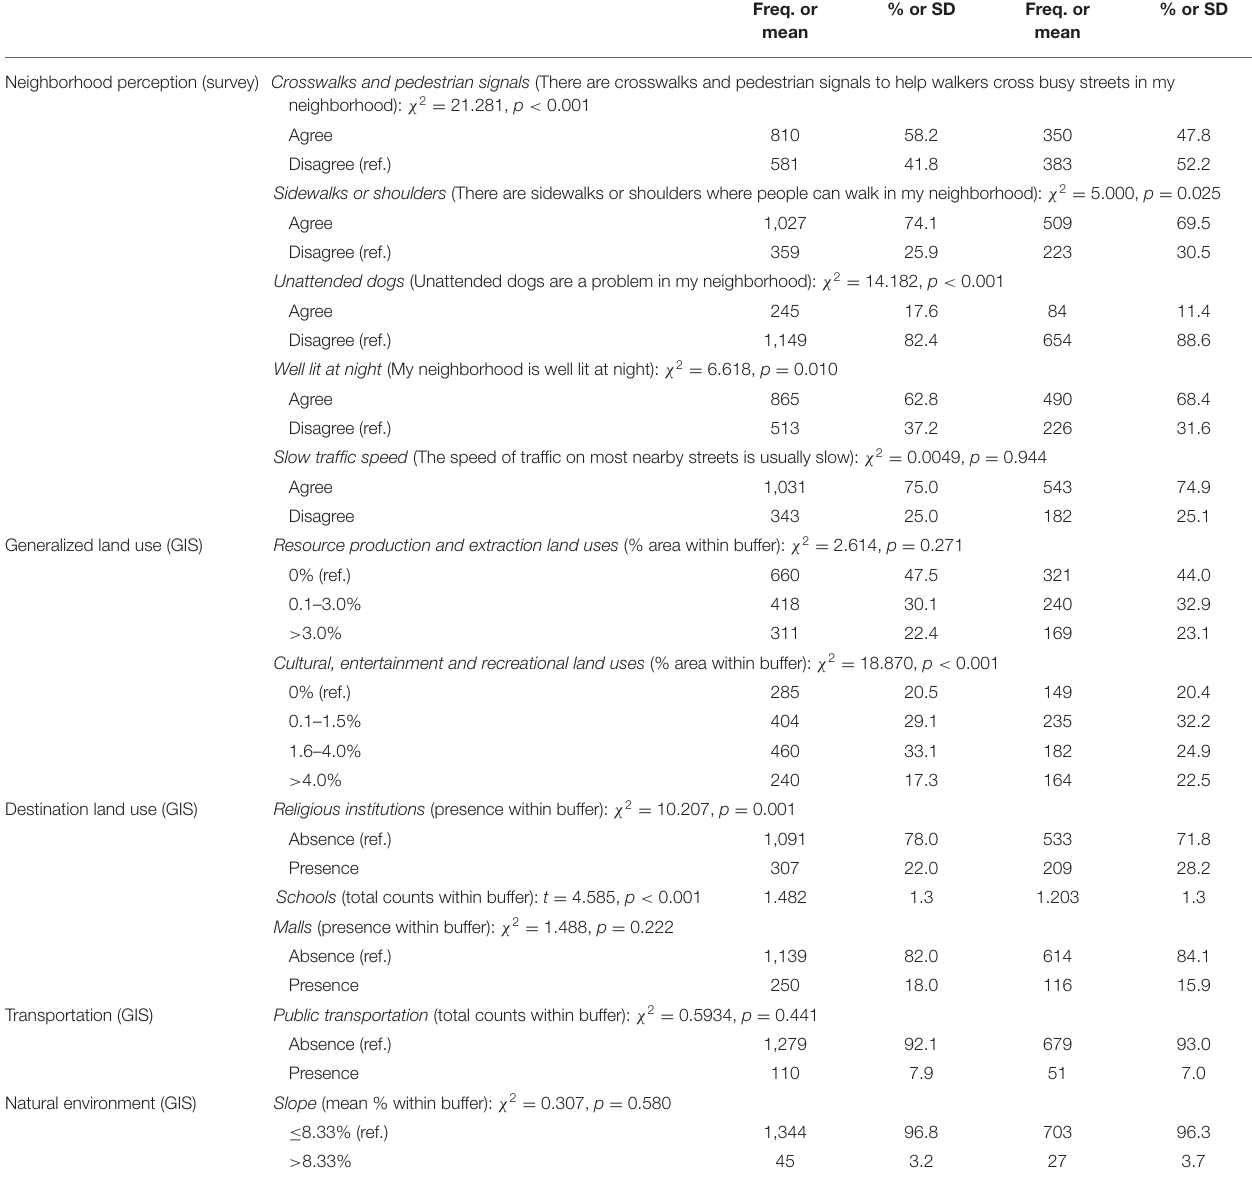
Freq. or % or SD Freq. or % or mean mean